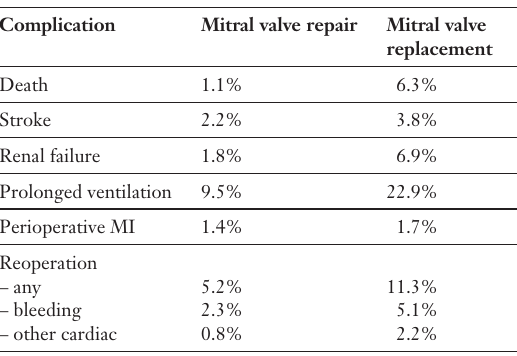
In-hospital morbidity and mortality for first time isolated mitral valve surgery (STS